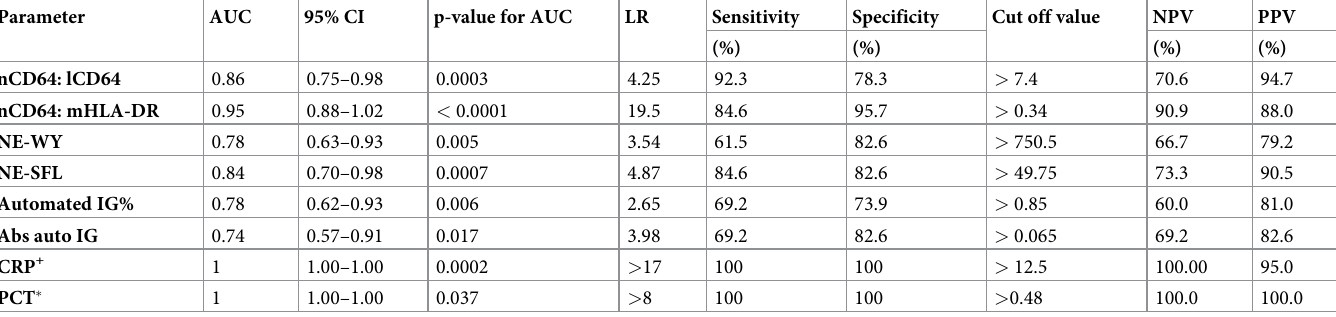
Table 3. ROC curve analysis assessing the various biomarkers among patients with bacteremic infection compared to those with no evidence of bacterial infection. Parameter